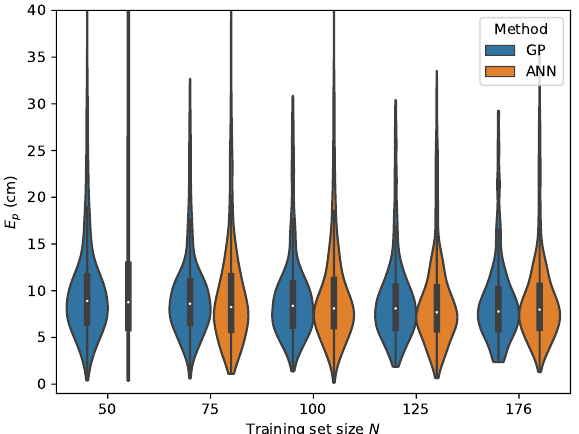
Figure 15. Cross-validation with set C where the r rel , max input features are used.